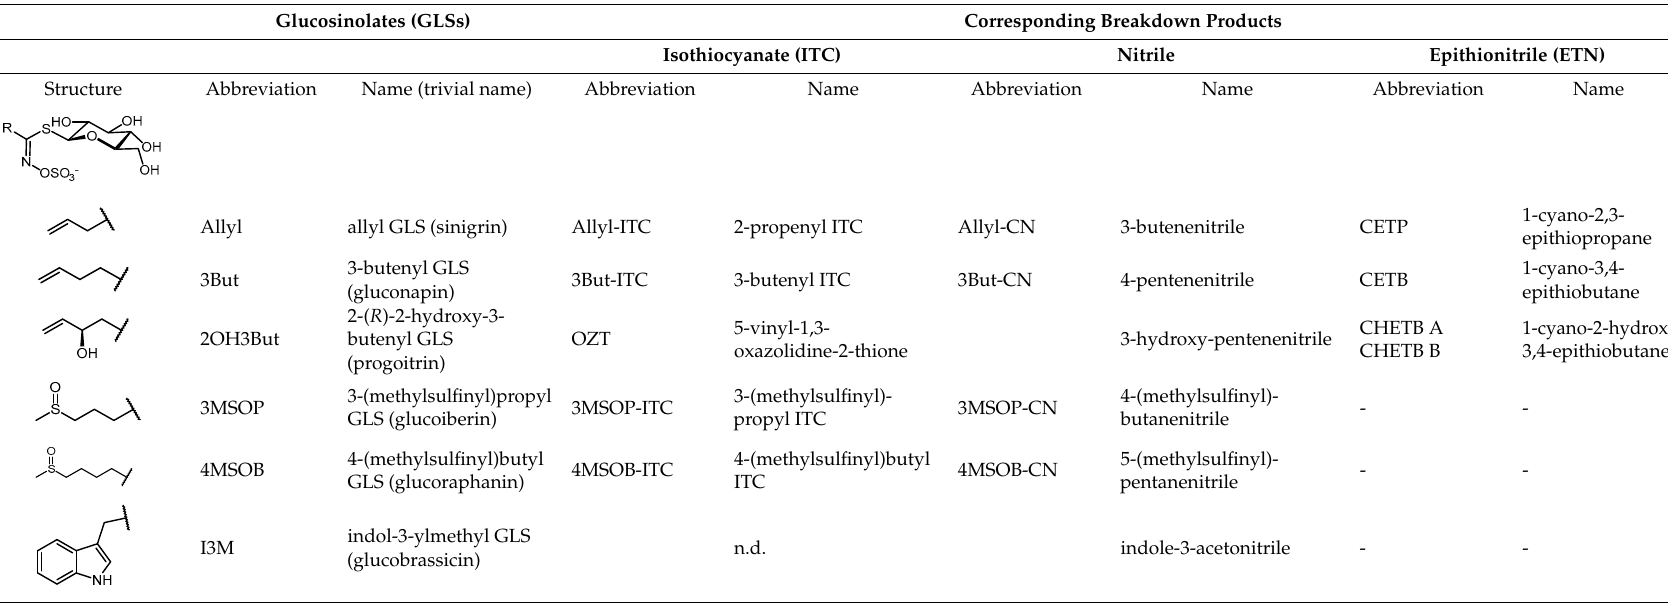
Table 3. Structures of main cabbage glucosinolates, their abbreviations, and their hydrolysis products analyzed in the present study. N.d.: Not detected. Glucosinolates (GLSs) Structure